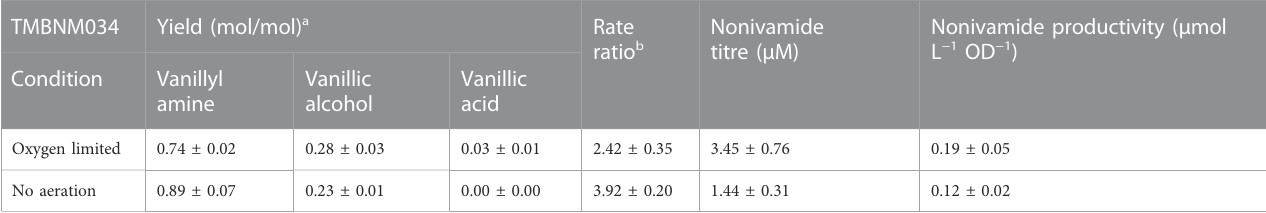
TABLE 3 Yield, rates and titers calculated for the combined amination and amidation for nonivamide production in bioreactor set-up. TMBNM034 Yield (mol/mol)